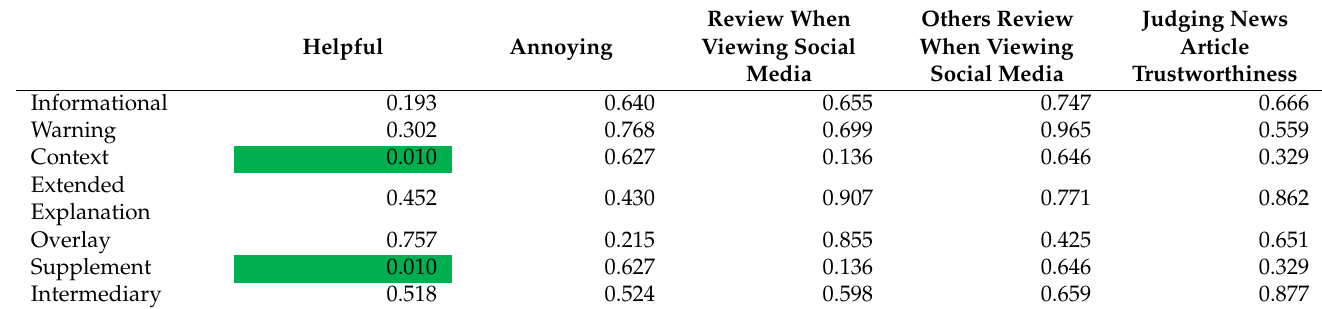
Table A6. Statistical significance calculations for age comparison data.